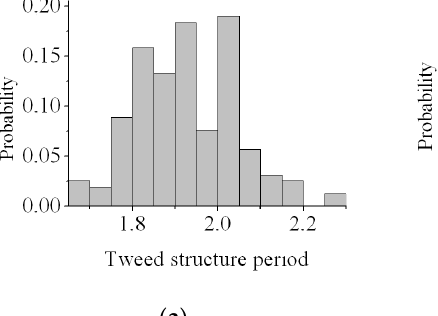
Figure 2. Histograms of the tweed structure period formed at temperatures of 233 ( a ), 296 ( b ) and 363 ( c ) K.